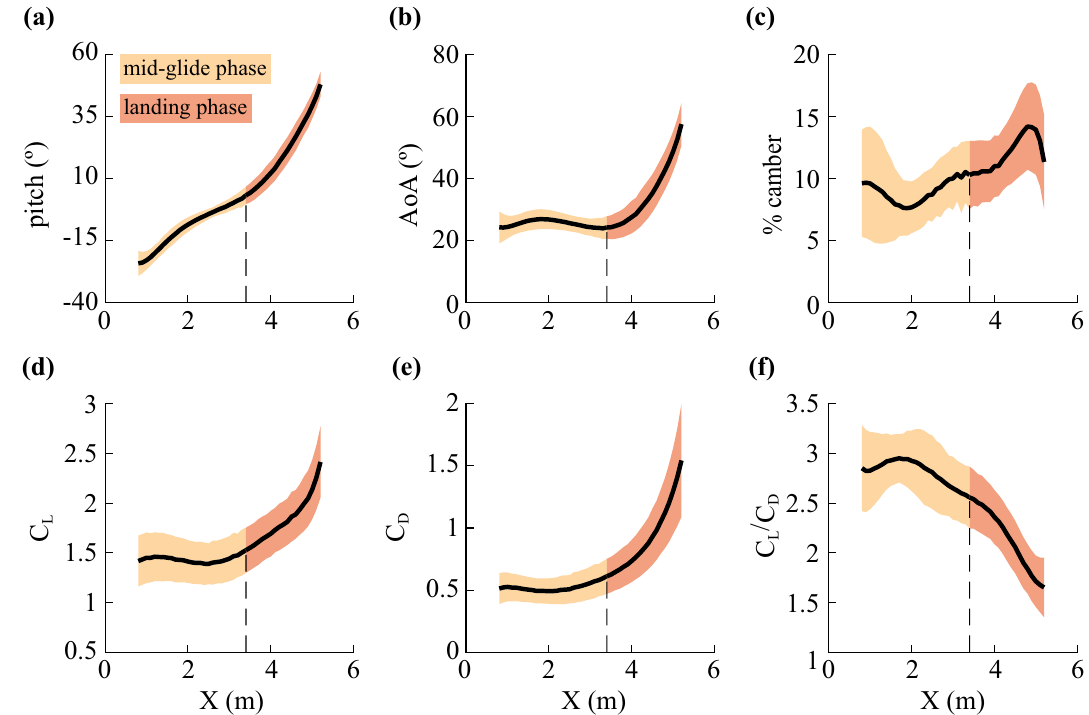
Figure 3. Average glide mechanics across all 14 individuals in the field motion capture arena. The solid black line shows the average value, and the shaded area shows ± 1 standard deviation. The vertical dashed line denotes the start of the landing phase calculated as the average of start of landing phase for all glides. Overall, the analysis covers ~ 82% of the complete glide. Panels ( a – c ) show the overall variation in pitch, AoA, and camber. Note the steady increase in pitch in the mid-glide phase and a mostly constant AoA of approximately 25° with varying percentage camber. Panels ( d – f ) show the change in average force coefficients and their ratio with glide progression. Note the steep drop in lift-to-drag ratio during the landing